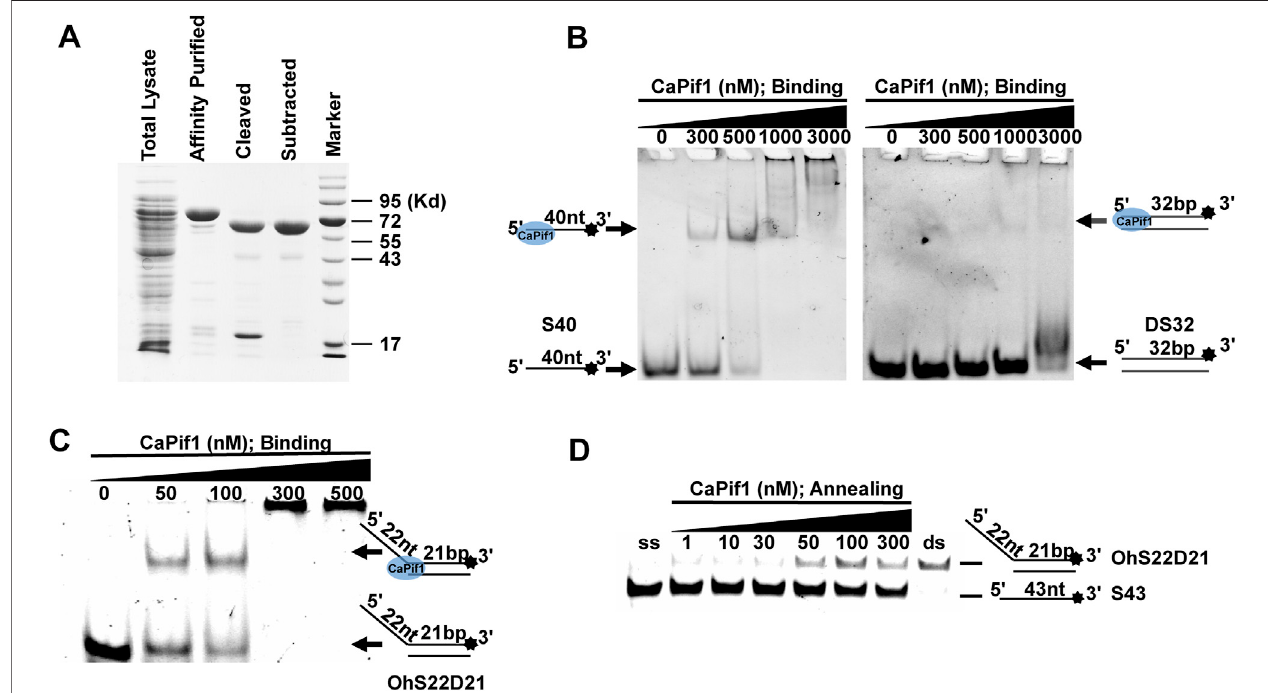
FIGURE1| Bindingandannealingactivityofpuri fi cationofCaPif1. (A) SDS-10%polyacrylamidegelstainedwithCoomassiebrilliantbluedye.Lanemarker:protein molecular mass markers (with masses, in kilodaltons, indicated on the right). (B – C) CaPif1 binding activity was detected by DNA of three substrates. Top of the arrow: CaPif1-DNAcomplexes;Bottomofthearrow:freeDNA.NativePAGE(Acr:Bis (cid:2) 39:1)6%,100 V,40 min. (D) AnnealingactivityofCaPif1.NativePAGE(Acr:Bis (cid:2) 39:1) 12%, 100 V, 80 min. Lane ds: OhS22D21; lane ss: S43 (see Methods for more details). The results of fi gures (B – D) were visualized by a ChemiDoc MP Imaging System (Bio-Rad, California, United